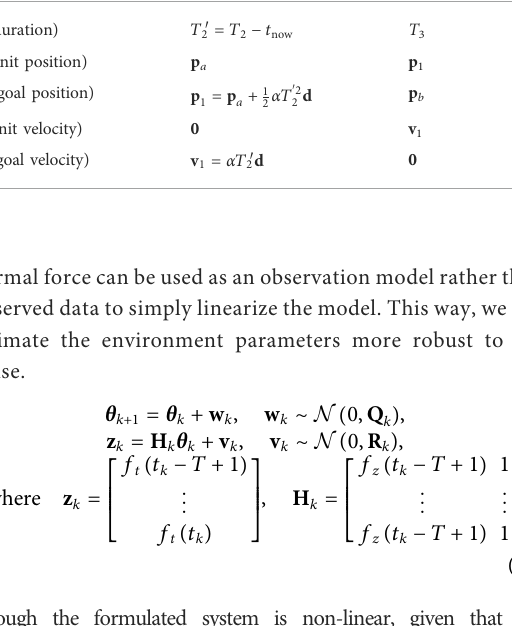
Frontiers in Robotics and